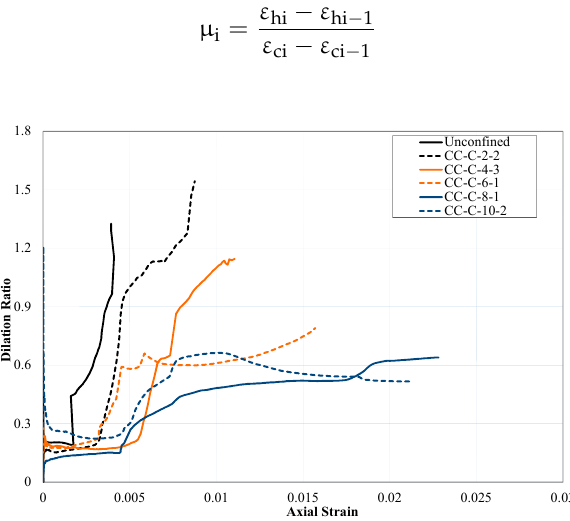
Figure 3. Dilation ratio-axial strain relationship in FRP confined HPFRCC.